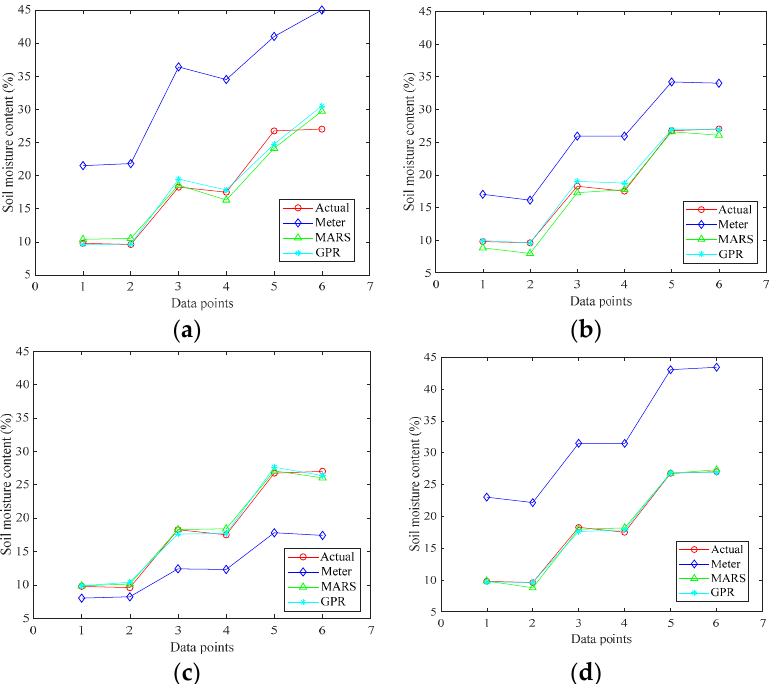
Figure 4. The comparison of soil moisture content by different approaches: ( a ) sensor A; ( b ) sensor B; ( c ) sensor C; and ( d ) sensor D.